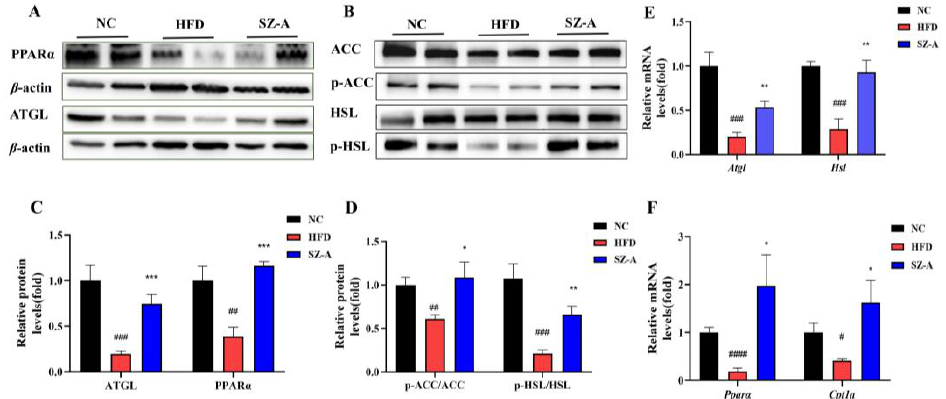
Figure 2. ( A ) Protein expressions of PPARα and ATGL in eWAT were determined using western blotting. ( B ) Protein expressions of ACC, p-ACC, HSL, and p-HSL in eWAT were determined using western blotting ( n = 5~6/group). ( C ) and ( D ) Protein expression histograms. ( E ) and ( F ) Relative mRNA expression levels of genes, including Atgl , Hsl , Pparα , and Cpt1a ( n = 4~6/group). Values represent mean ±SEM. (# p < 0.05, ## p < 0.01, ### p < 0.001, #### p < 0.0001, HFD vs NC and * p < 0.05, ** p < 0.01, *** p < 0.001 HFD vs SZ-A ).